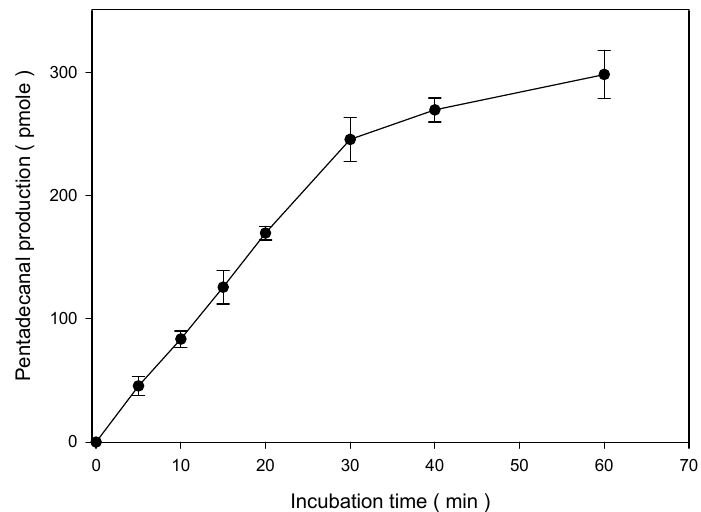
Figure 5. Time course of pentadecanal production in F9-4 cell lysate proteins. S1PL was measured with 50 µg of F9-4 cell lysate proteins and 20 µM C17-Sa1P for the indicated time. We stopped the 5,5-dimethyl CHD reaction by adding 200 µL of ethanol. Lipid aldehyde derivatives were extracted via solid-phase extraction and analyzed using C18 reverse-phase HPLC. The data represent the mean ± SD of triplicate analyses.